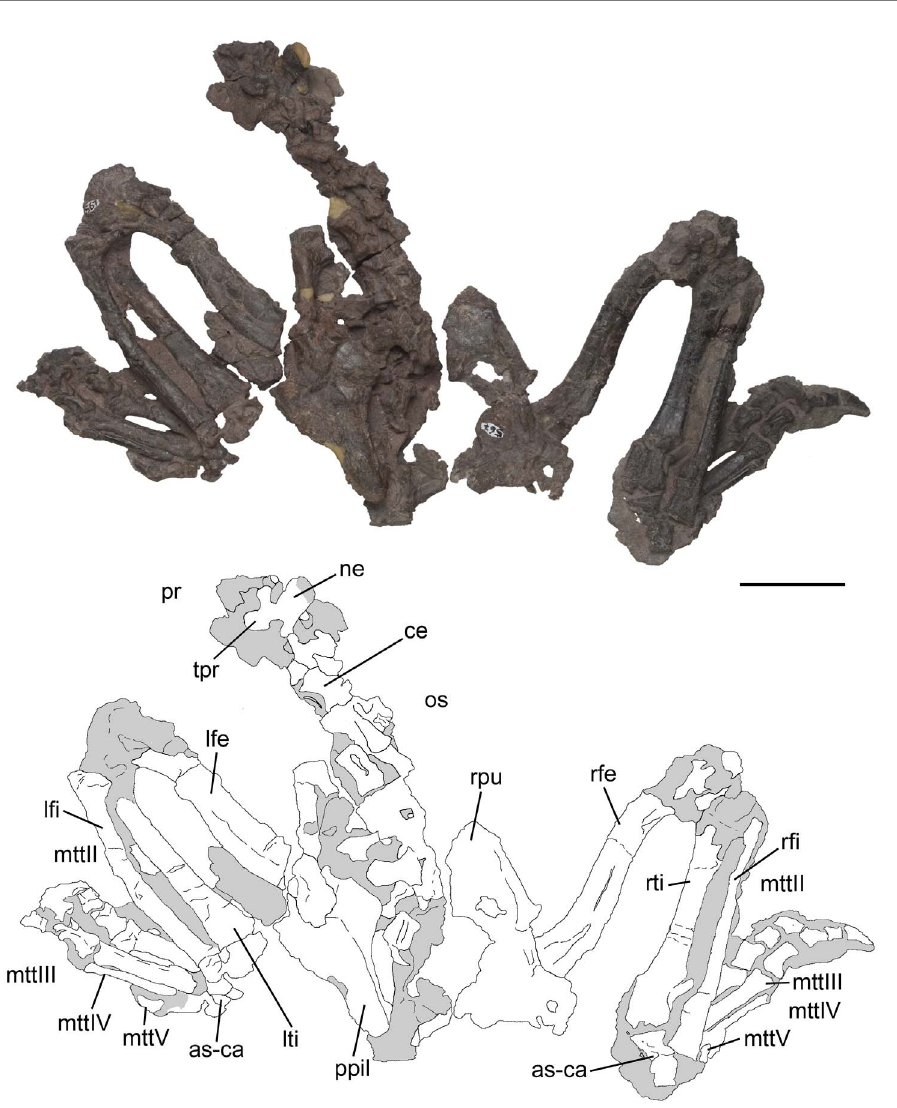
Figure 8. Pelvic girdle and hindlimbs of Pseudochampsa ischigualastensis (PVSJ 567) in dorsal view. Abbreviations: as-ca, astragalus-calcaneum; ce, centrum; mttII–V, metatarsals II–V; lfe, left femur; lfi, left fibula; lti, left tibia; ne, neural spine; os, osteoderm; ppil, postacetabular process of ilium; pr, prezygapophysis; rfe, right femur; rfi, right fibula; rpu, right pubis; rti, right tibia; tp, transverse process. Scale bar equals 5 cm.